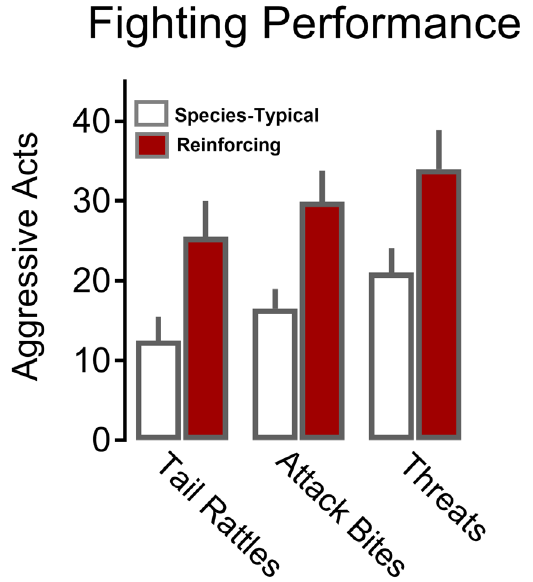
Figure 2. Aggression that serves as a reward is more intense than species-typical fighting. Aggressive behaviors, including tail rattle, sideways threat, and attack bites, are substantially increased when outbred male mice work during a fixed interval schedule for the opportunity to fight a conspecific (dark bars) as compared with species-typical levels of agonistic behavior that occurs during spontaneous aggression (open bars). Adapted from Fish et al. 81 with permission from Springer-Verlag.